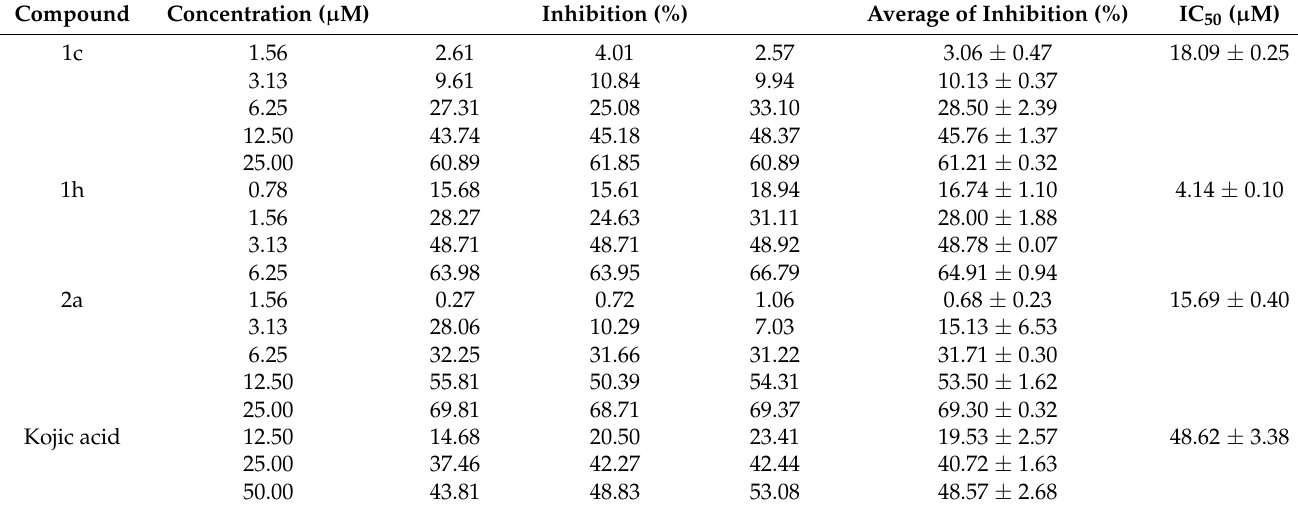
Table 3. Inhibitory effects of urolithin derivatives 1c and 1h, o -phenylbenzyl alcohol 2a, and kojic acid on mushroom tyrosinase activity.